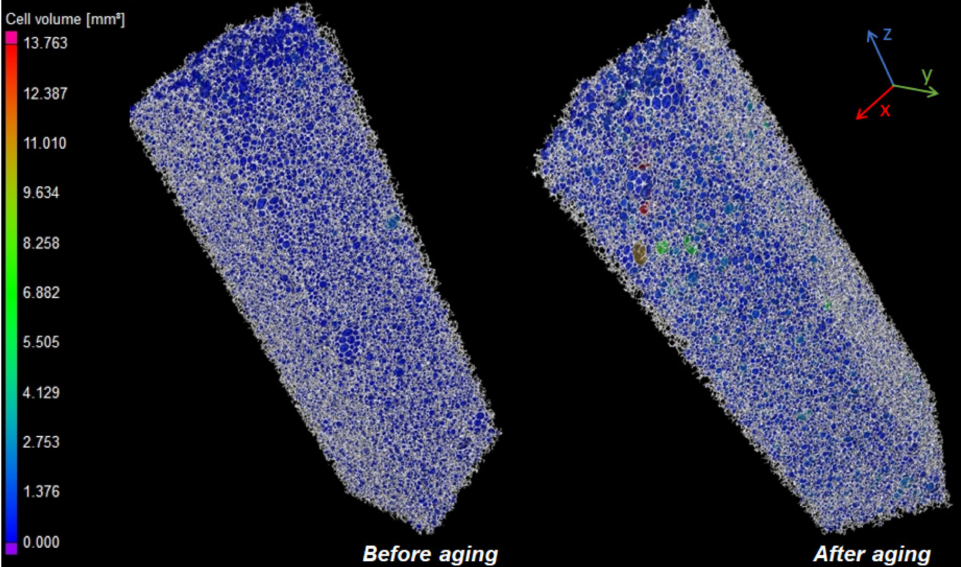
Figure 4. Cell structure of the NCO-1.0 sample examined with a micro-CT before and after dry heat